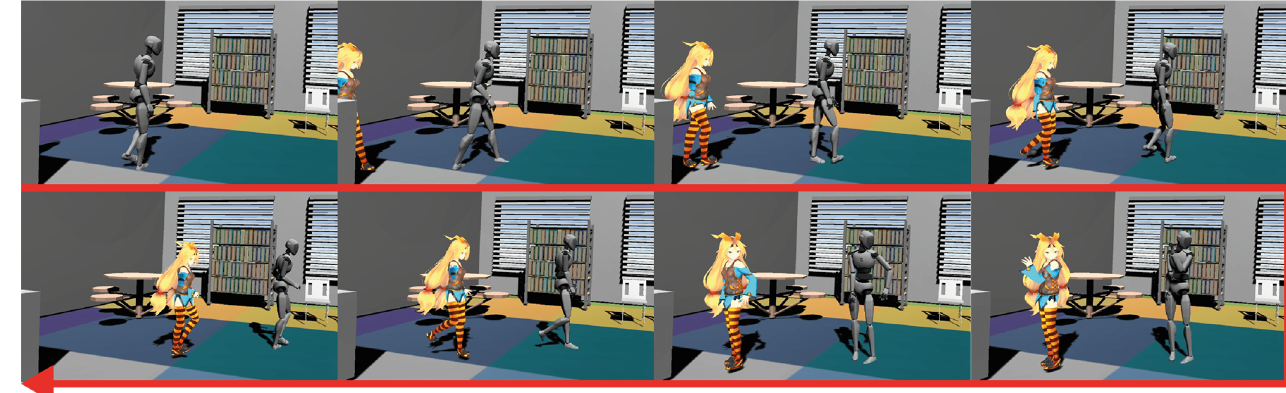
Figure 5. Real-time motion capture in